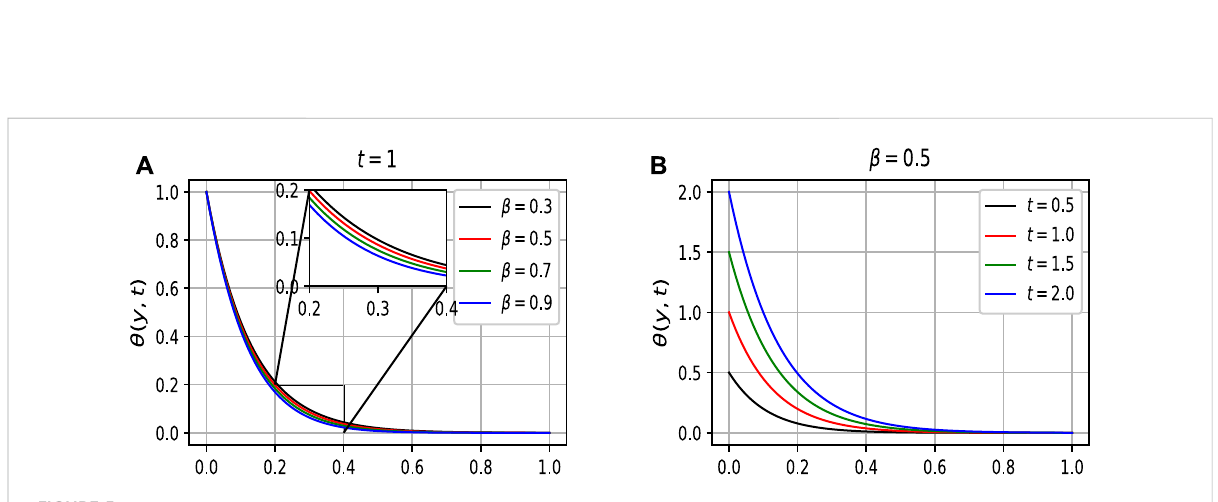
FIGURE 5 The behaviour of the boundary layer temperature as the parameters β and time ŧ